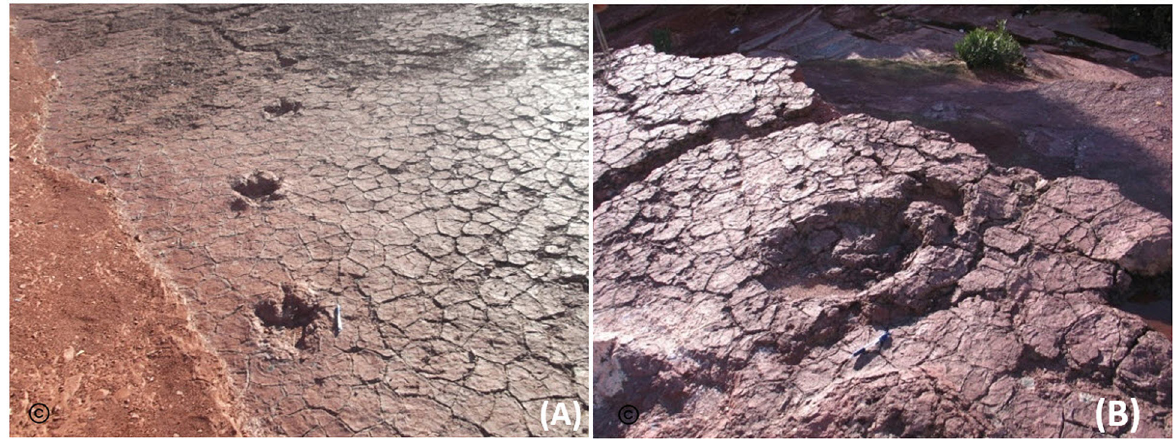
Fig. 6. The geosites of dinosaur footprints and tracks of Aït